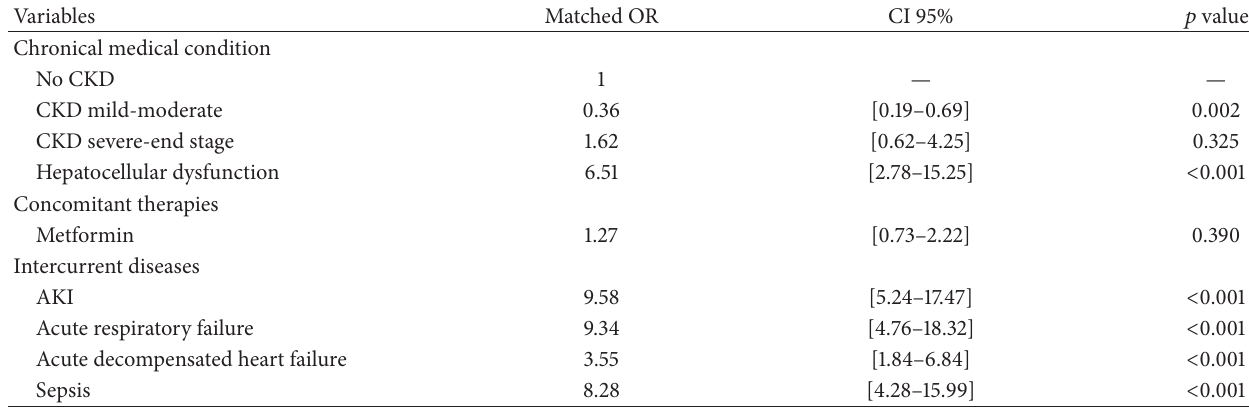
Table 2: Conditional logistic regression of covariates ( 𝑁 = 906